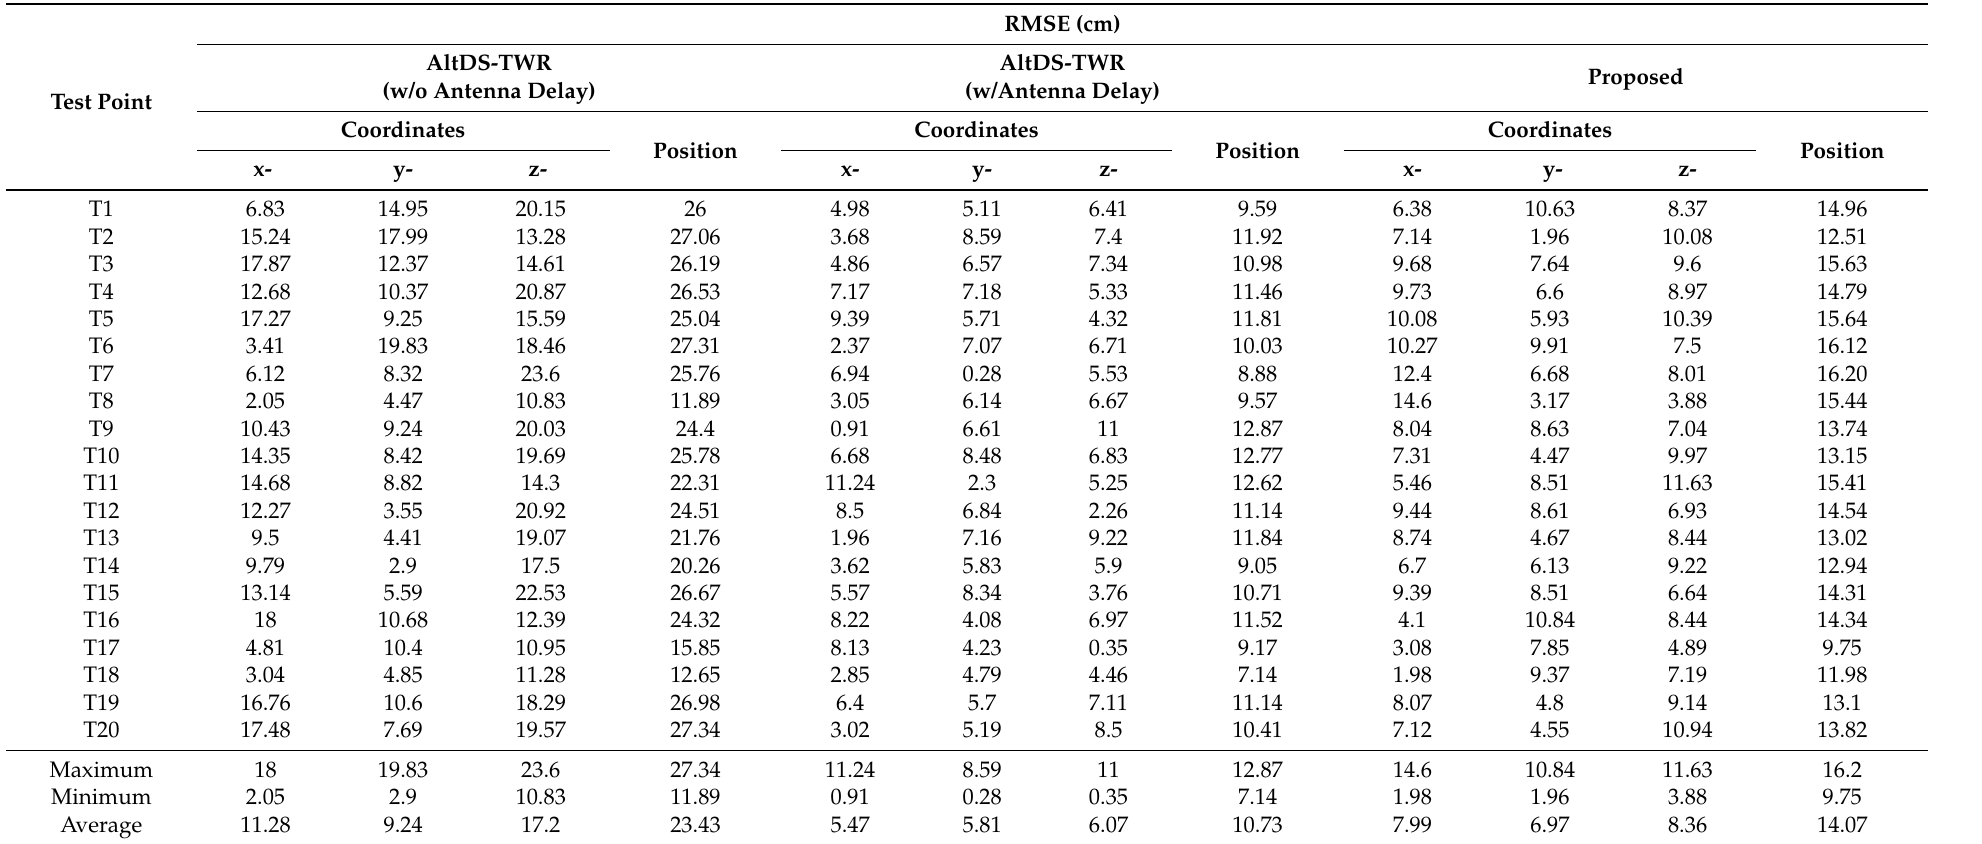
Table 3. Comparison of RMSEs of the xyz-coordinates and position estimations of the mobile node from AltDS-TWR (w/o Antenna Delay), AltDS-TWR (w/Antenna Delay), and the proposed